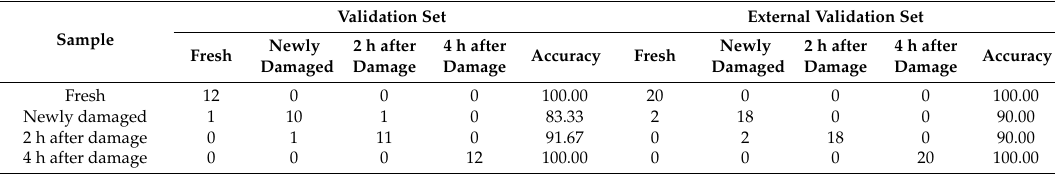
Table 4. Discrimination results for different quality litchis with confusion